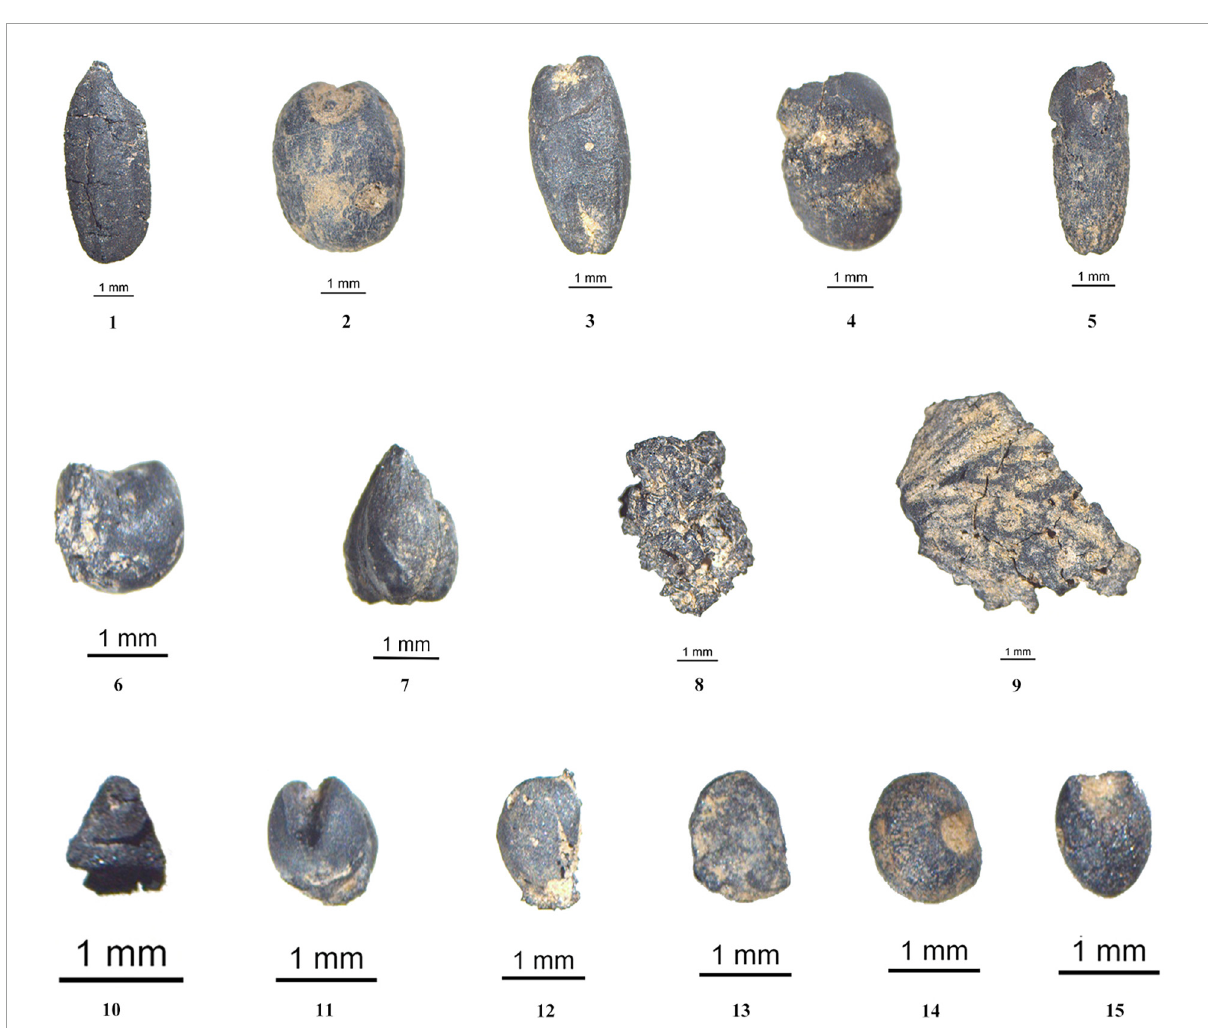
FIGURE4 Images of Wanfunao plant remains unearthed in part. (1) Oryza sativa , (2) Triticum aestivum , (3) Hordeum vulgare , (4) Vigna angularis , (5) Avena sativa , (6) Panicum miliaceum , (7) Fagopyrum esculentum , (8) foxtail millet lump, (9) Armeniaca mume , (10) rice spikelet base, (11) Setaria italica , (12) Melilotus sp., (13) Lespedeza sp., (14) Galium sp., and (15) Panicum bisulcatum .